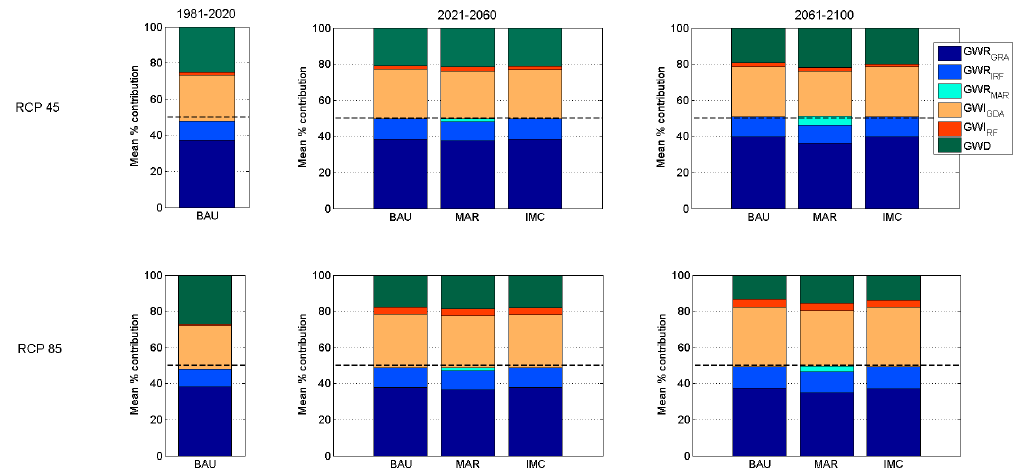
Figure 8. Top panels: percentage contribution to aquifer mass balance within each adaptation scenario (starting in 2020) under the RCP 4.5 emission scenarios for the periods 1981–2020 (top-right panel), 2021–2060 (top-middle panel) and 2061–2100 (top-left panel) from (same layout of Figure 4a). Lower panels: same analysis under the RCP 8.5 emission scenarios. By construction, the 50% line indicates equilibrium between the Resources (cold colors) and Allocations (hot and green colors) components.